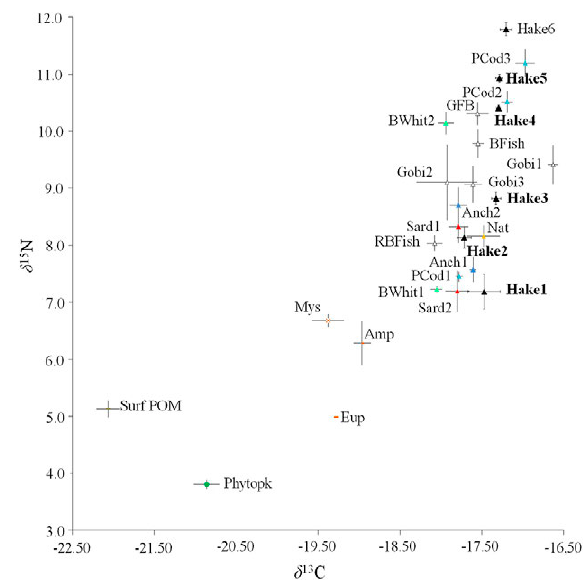
6. – Mean (±SE) values of δ 15 N (‰) and δ 13 C (‰) for main prey of hake trophic web in the GoL in 2005. Codes: Surf POM, Surface Particulate Organic Matter; Phytopk, Phytoplankton; Zoopk, Zooplankton; Amp, Amphipods; Eup, Euphausiids; Mys, Mysids; Nat, Natantia; Hake1, Hake 5-6 cm; Hake2, Hake 7-14 cm; Hake3, Hake 15-24 cm; Hake4, Hake 25-39 cm; Hake5, Hake 40-49 cm; Hake6, Hake 50-74 cm; Gob1, Deltentosteus quadrimaculatus ; Gob2, Gobius niger ; Gob3, Lesueurigobius friesii ; GFB, Greater Forkbeard; BFish, Boar Fish; RBFish, Red Bandfish; Sard1, Sar- dine <13.5 cm; Sard2, Sardine ≥ 13.5 cm; Anch1, Anchovy <14 cm; Anch2, Anchovy ≥ 14 cm; BWhit1=Blue Whiting <15 cm; BWhit2, Blue Whiting ≥ 15 cm; PCod1, Poor Cod ≤ 7 cm; PCod2, Poor Cod 8-13 cm; PCod3, Poor Cod ≥ 14